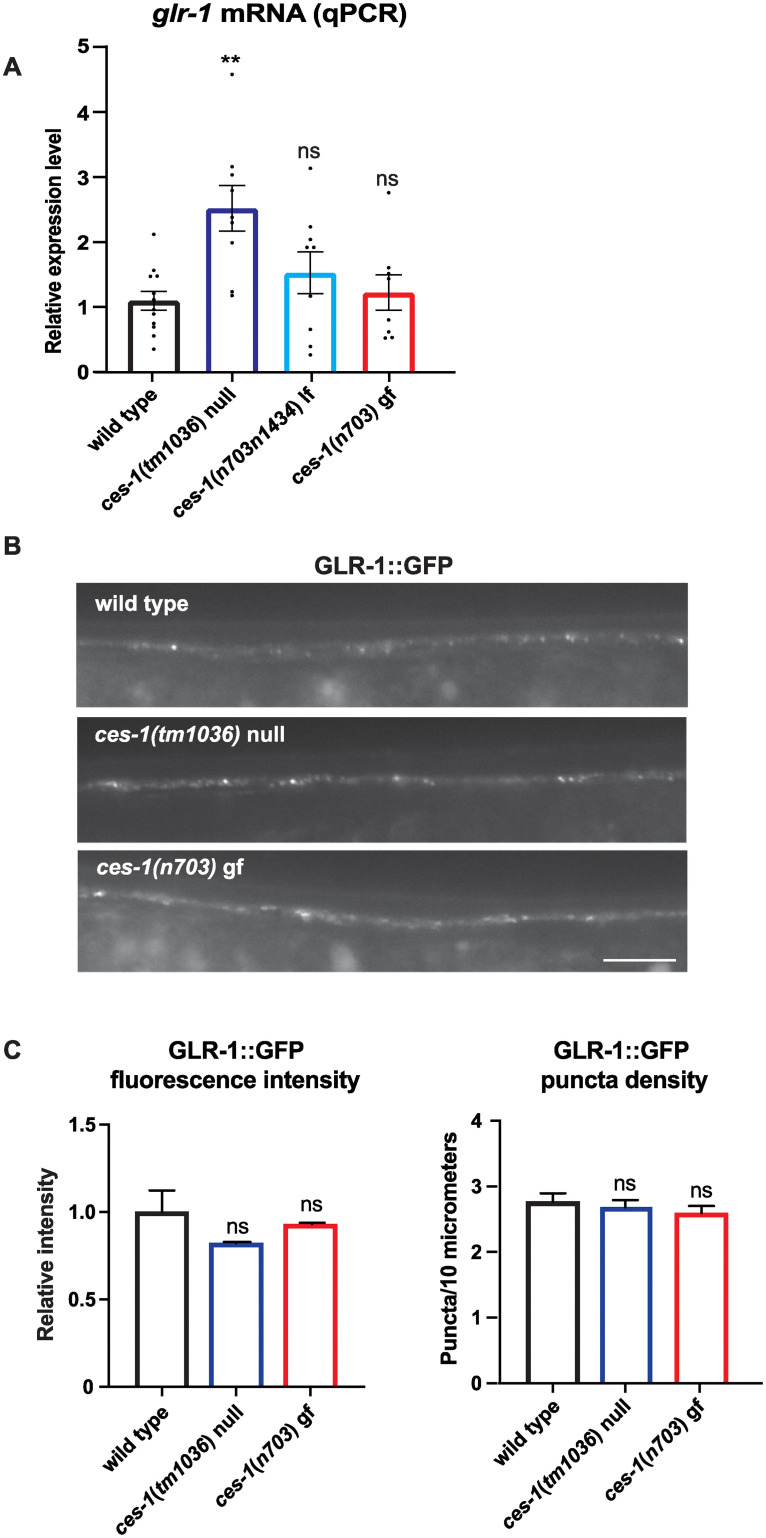
glr-1 mRNA and GLR-1::GFP levels are not decreased in ces-1 loss-of-function mutants.(A) Real-time qPCR for glr-1 mRNA in wild type and ces-1 mutants. Data represents 4 experiments and 3 biological replicates normalized to 2 reference genes (ΔΔCt versus act-1 and ama-1). (B) Representative images of GLR-1::GFP (pzIs12) in the ventral nerve cord of wild type and ces-1 mutants. (C) Quantitation of peak fluorescence intensity (Normalized) and density of GLR-1::GFP puncta in the ventral nerve cord in wild type and ces-1 mutants. N = 56 animals for wild type, N = 28 for ces-1(tm1036), and N = 31 for ces-1(n703). Error bars represent SEM. “ns” indicates no statistically significant difference from wild type (p>0.05). Asterisks above the bar indicate values that differ significantly from wild type (**p<0.005). One-way ANOVA with Dunnett’s multiple comparisons test was used to compare means in (A). Tukey-Kramer test was used to compare means in (C).